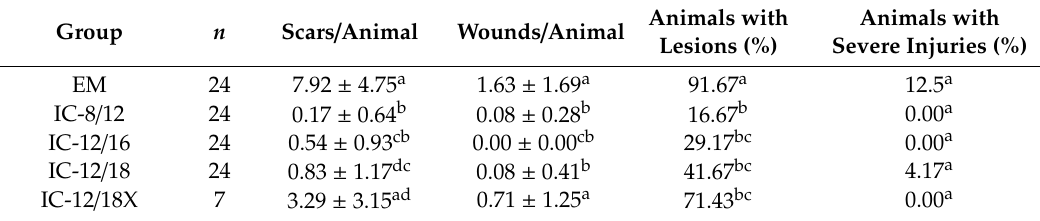
Animals with Animals with Lesions (%) Severe Injuries (%)